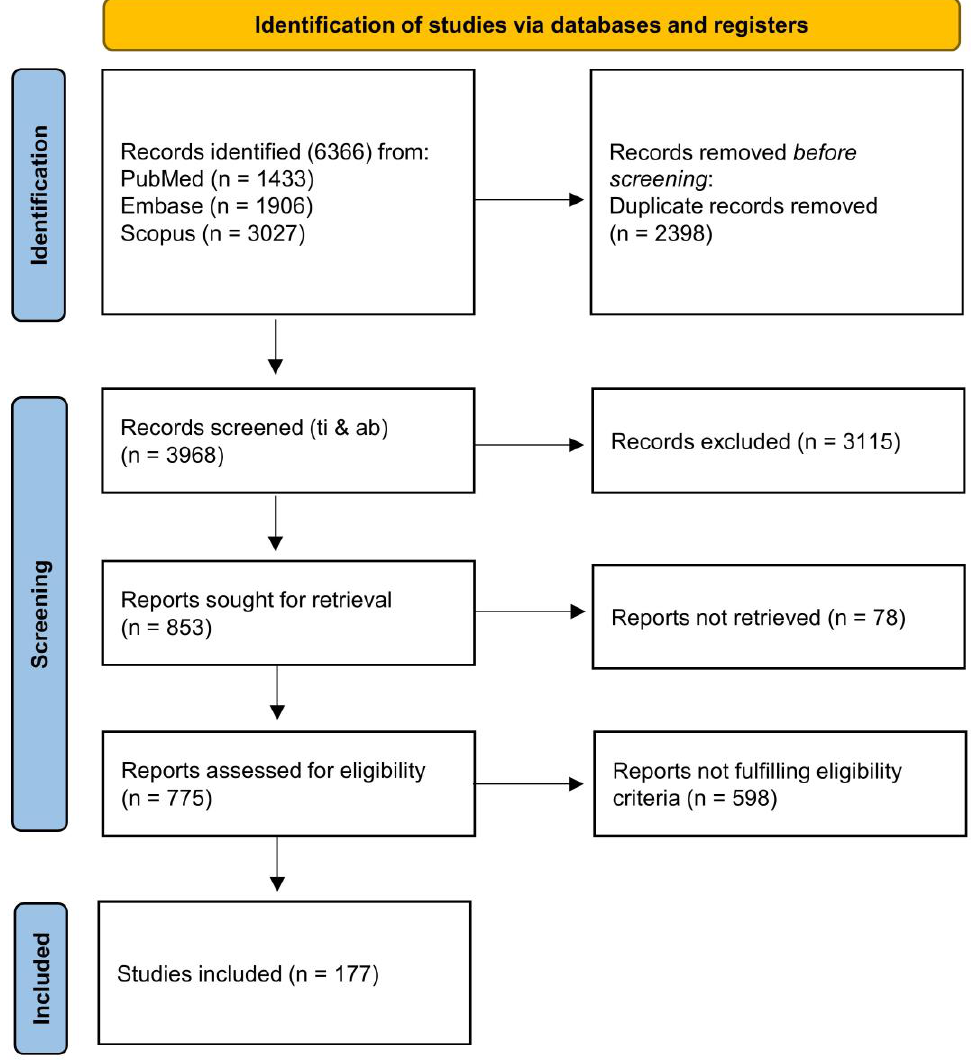
Figure 1. PRISMA flow diagram outlining the selection process through the different phases of the systematic review.